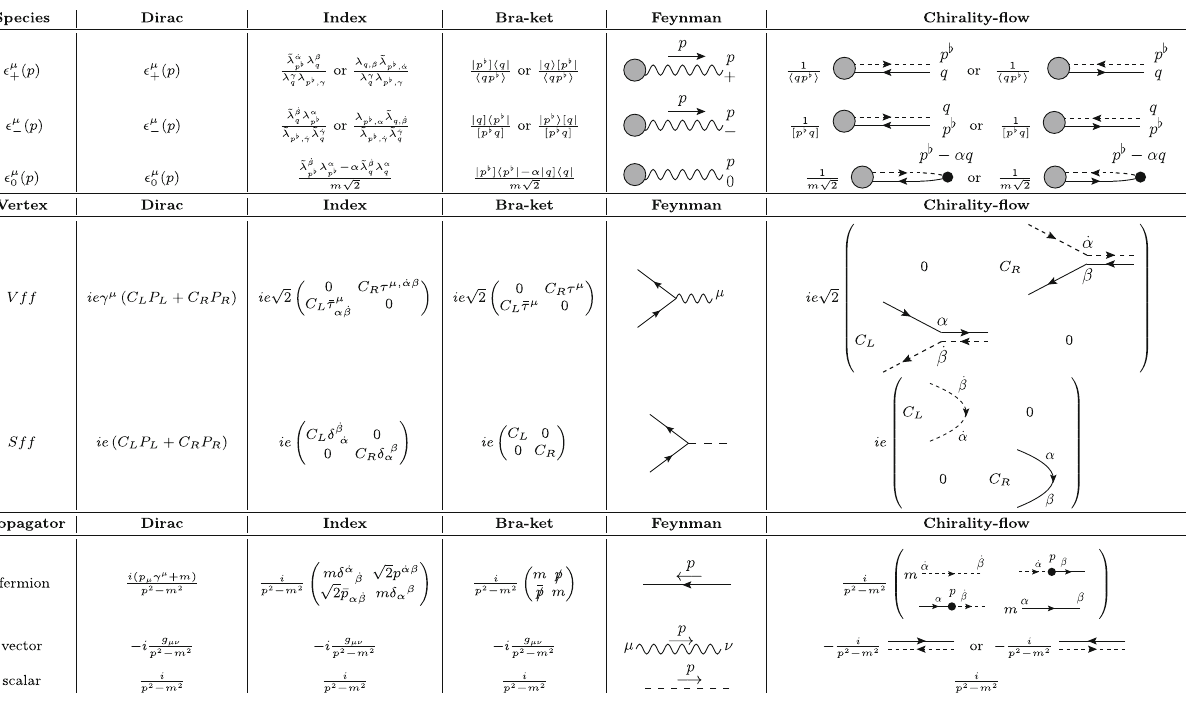
Table 3 Part one of the electroweak “Rosetta Stone” translating the chirality-flow notation to widely-used spinor-helicity notations. To translate the polarization vectors to the helicity basis, replace p (cid:9) → p f and q → p b . Incoming polarization vectors of spin J s are equal to outgoing ones of spin − J s . Massless polarization vectors are given by replacing p (cid:9) → p , and q → r where r is an unphysical